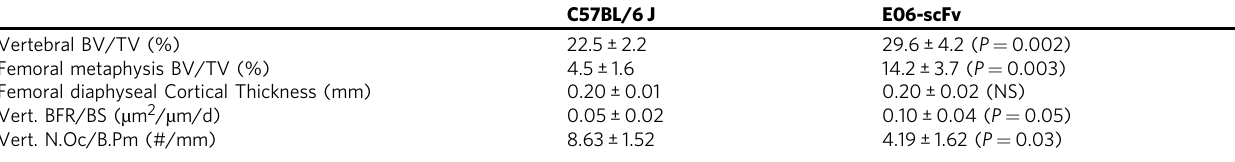
Table 1 E06-scFv increases cancellous bone mass by increasing bone formation rate and decreasing osteoclasts